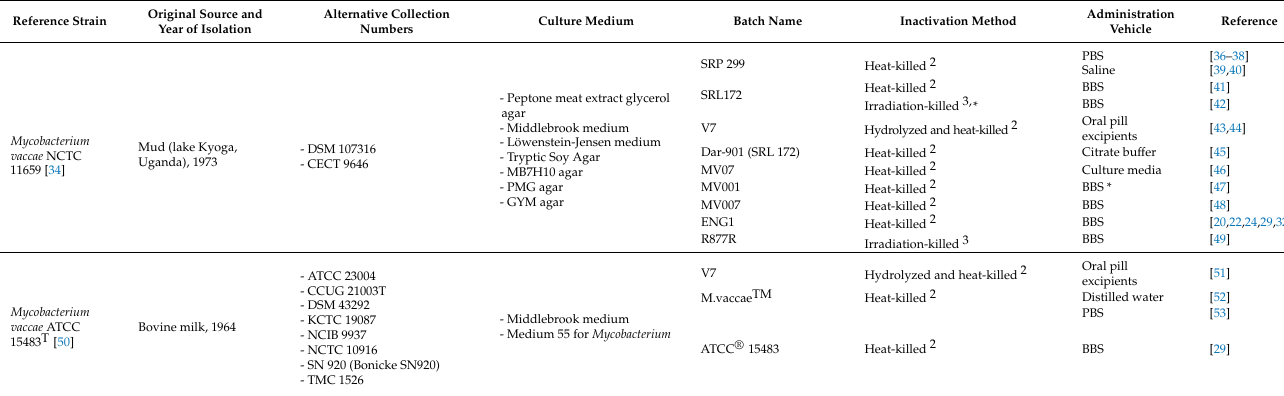
Table 1. List of alternative names of the mycobacterium strains used in the present review article and related details 1